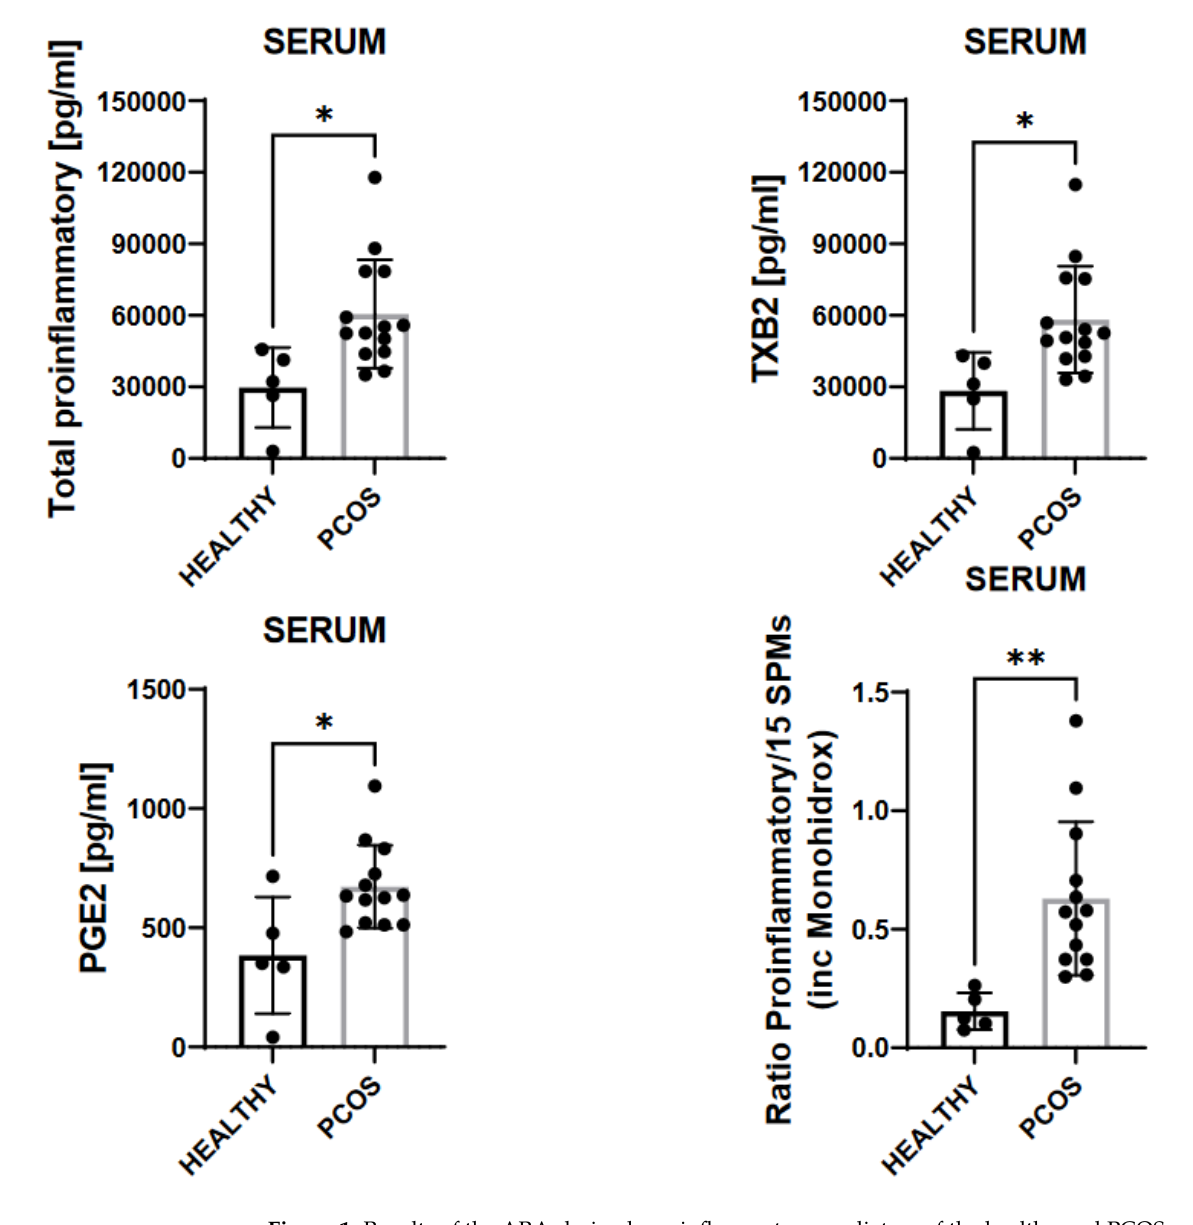
Figure 1. Results of the ARA-derived pro-inflammatory mediators of the healthy and PCOS patients. * = significant difference ( p < 0.05); ** p < 0.005.